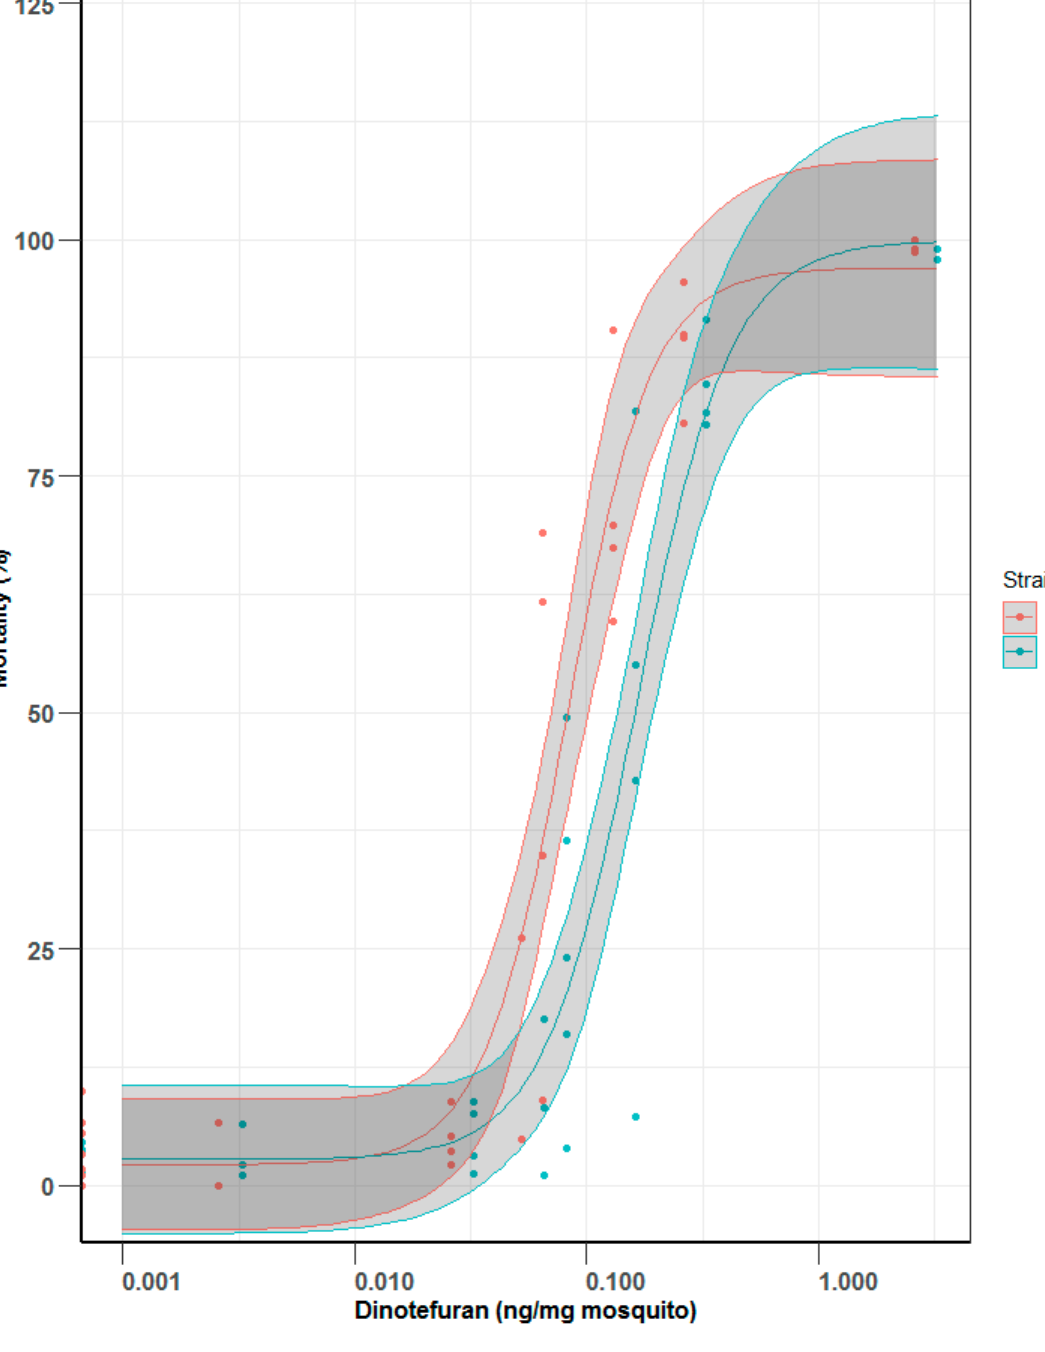
Figure 3. Mortality comparison between Kisumu and VK7 strains when fed on sugar solution spiked with dinotefuran at known concentrations, resulting in doses of dinotefuran in nanograms per milligram of mosquito. Central lines of each curve represent the dose response of each species. Black lines indicate LD 50 values; red refers to the mortality curve of Kisumu; blue refers to the mortality curve of VK7 2014. The shaded areas of each curve represent 95% CI values, generated by R software using the ggplot2 package